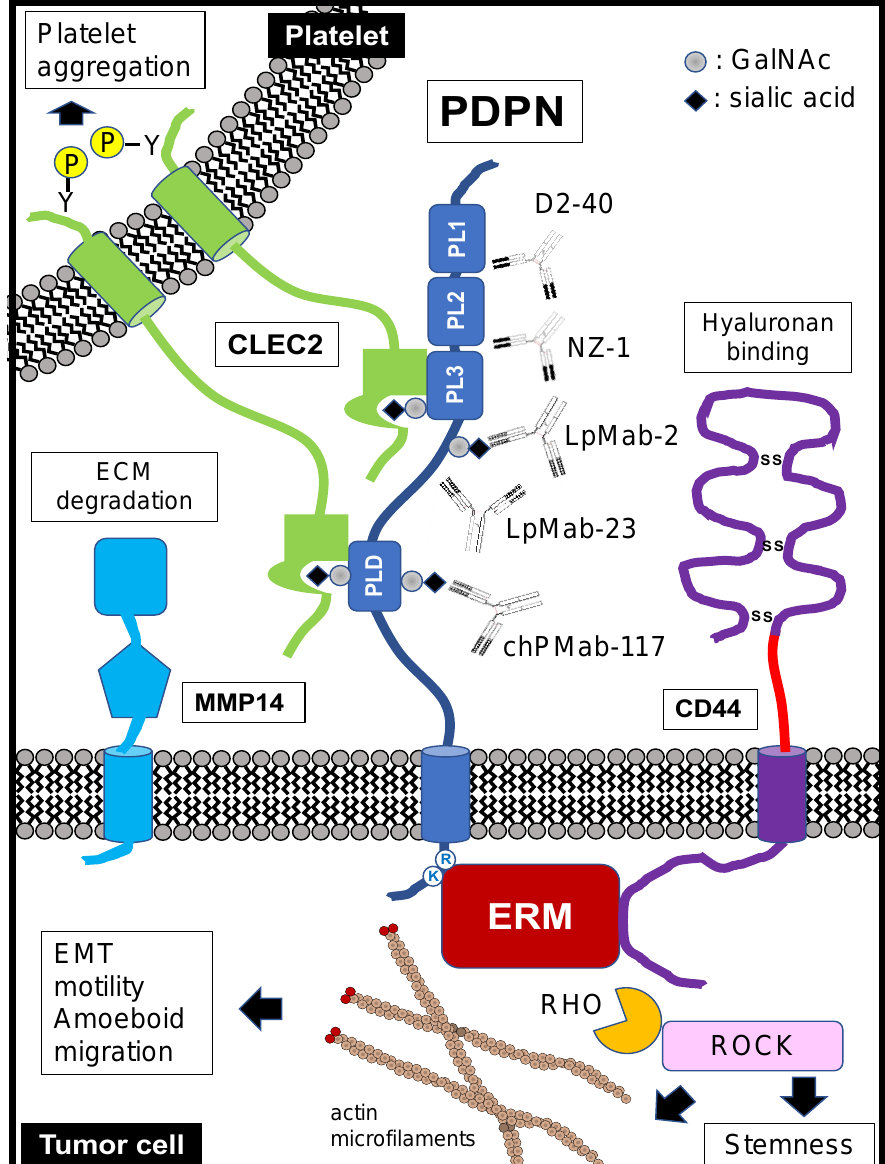
Figure 1. Schematic representation of podoplanin (PDPN) structure and functions. PDPN is a type I transmembrane glycoprotein consisting of an extracellular domain, a transmembrane portion, and a short cytoplasmic tail. The PDPN extracellular domain contains PLAG1-3 (PL1, PL2, and PL3) domains and PLAG-like domain (PLD). C-type lectin-like receptor 2 (CLEC-2), a platelet receptor, recognizes both the sialylated PLAG3 domain and PLD with the adjacent PDPN peptides, inducing CLEC-2 tyrosine phosphorylation and platelet aggregation. The intracellular domain of PDPN contains basic residues (RK), which function as binding sites for ezrin, radixin, and moesin (ERM) family proteins that modulate RHO GTPase activity and promote actin cytoskeleton reorganization to promote cell migration, motility, and EMT. PDPN interacts with hyaluronan receptor CD44 and matrix metalloproteinase 14 (MMP14), promoting hyaluronan-binding and extracellular matrix (ECM) degradation, respectively. Anti-PDPN mAb NZ-1 recognizes the PLAG2/3 domain, exhibits a neutralizing activity for PDPN–CLEC-2 interaction, and inhibits PDPN-induced platelet aggregation and metastasis. Anti-PDPN mAb D2-40 identifies the PLAG1/2 domain and is widely employed for immunohistochemistry. A cancer-specific mAb (CasMab) to PDPN, LpMab-2, recognizes a glycopeptide (Thr55-Leu64) of human PDPN. A CasMab to PDPN, LpMab-23 recognizes a naked peptide of human PDPN (Gly54–Leu64), especially Gly54, Thr55, Ser56, Glu57, Asp58, Arg59, Tyr60, and Leu64 of PDPN, and is a critical epitope of LpMab-23. A CasMab to PDPN, chPMab-117 recognizes the glycopeptide of PDPN (Ile78-Thr85), which includes O -glycosylated